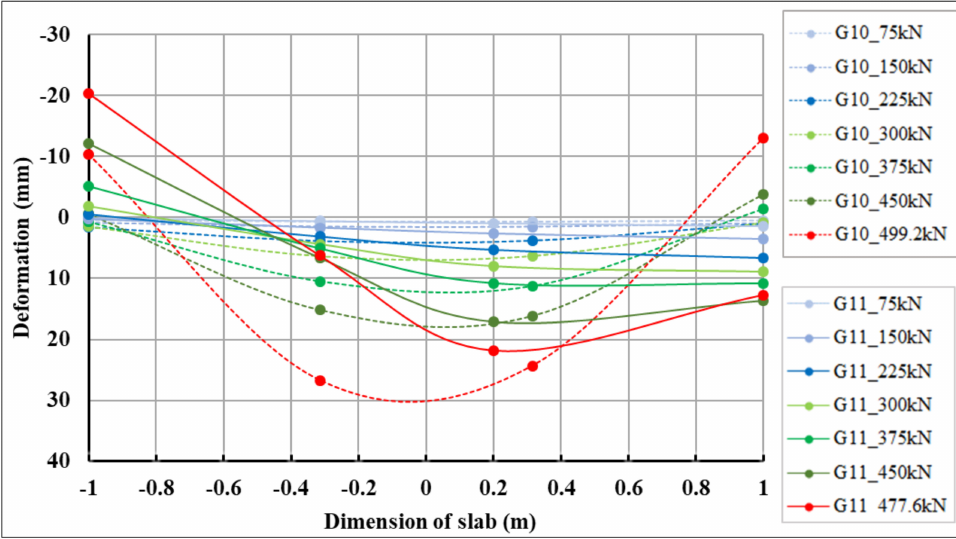
Figure 17. Comparison of 2D longitudinal-deformation sections of centrically loaded slab G10 and eccentrically loaded slab G11 for track sensors 03–42. Table 8. Deformation of centrically loaded slab G10 and eccentrically loaded slab G11 for track sensors 03–42.